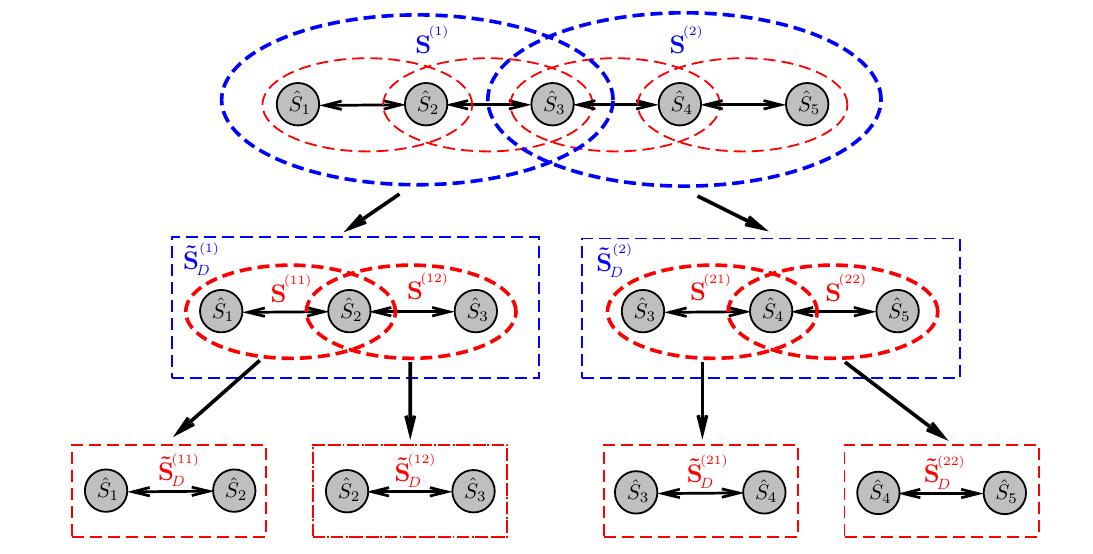
Figure 4: Decoupling expansion for multi-overlapping decomposition